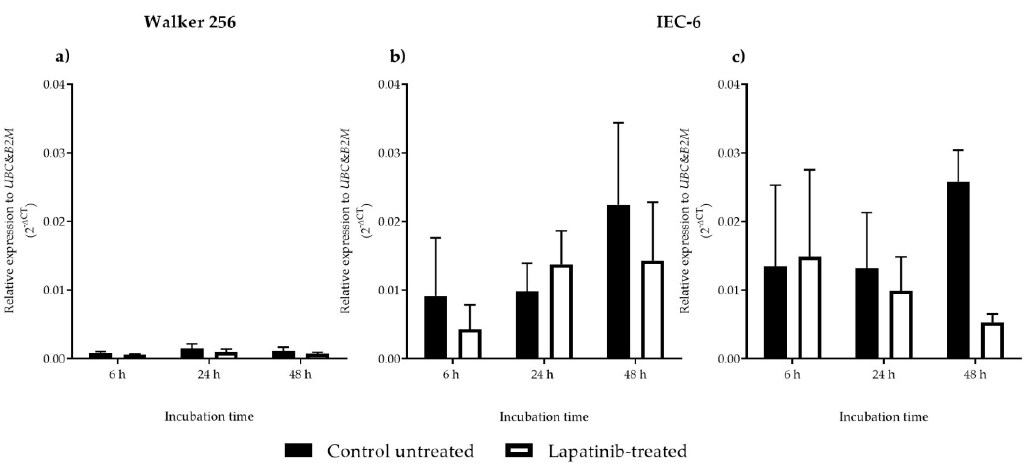
Figure 3. ( a ) ErbB2 mRNA expression in control untreated and lapatinib-treated Walker 256 cells; ( b ) ErbB1 and ( c ) ErbB2 mRNA expression in control untreated and lapatinib-treated IEC-6 cells. Data presented as mean ± S.E.M ( n = 4).